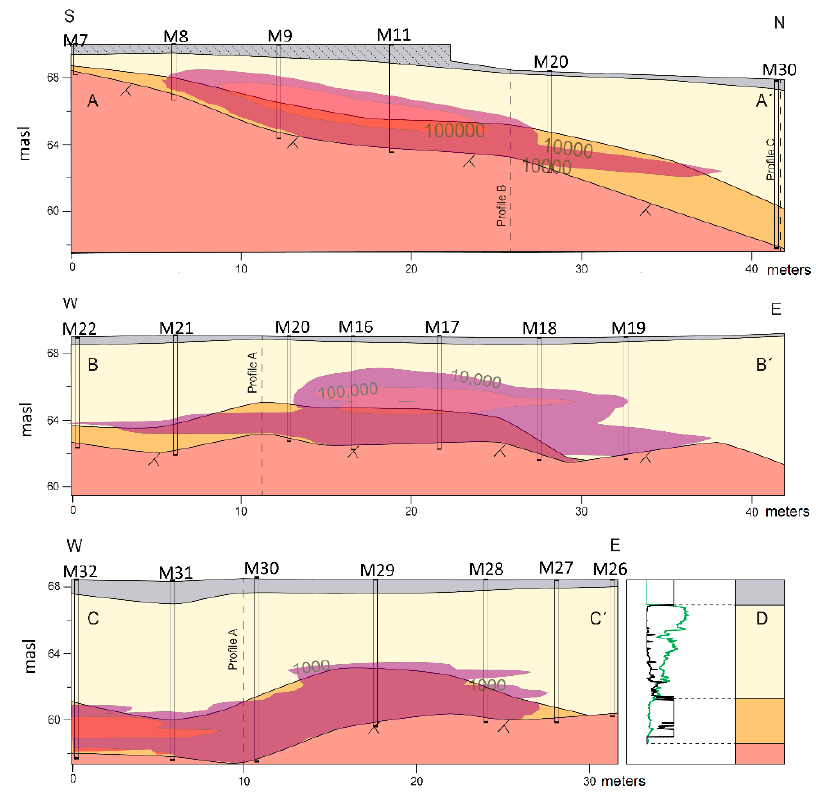
Figure 2. Geological and contaminant sections interpolated from MIP sounding data. The information about the geology (electrical conductivity (green mS / m) and estimated hydraulic conductivity (black, m / day)) is sampled every 1.5 cm and the information about the contamination (purple shows total concentration of PCE, TCE, DCE and VC in µ g / l) is sampled every 30 cm. The bedrock (red), bottom coarse unit (orange), mixed fine unit (light yellow) and coarse filling unit (grey) are interpreted based on the information about the geology based on the drill log (D). Profile locations are shown in Figure 1. The figure was generated by processing of the raw data from [27] through [28].